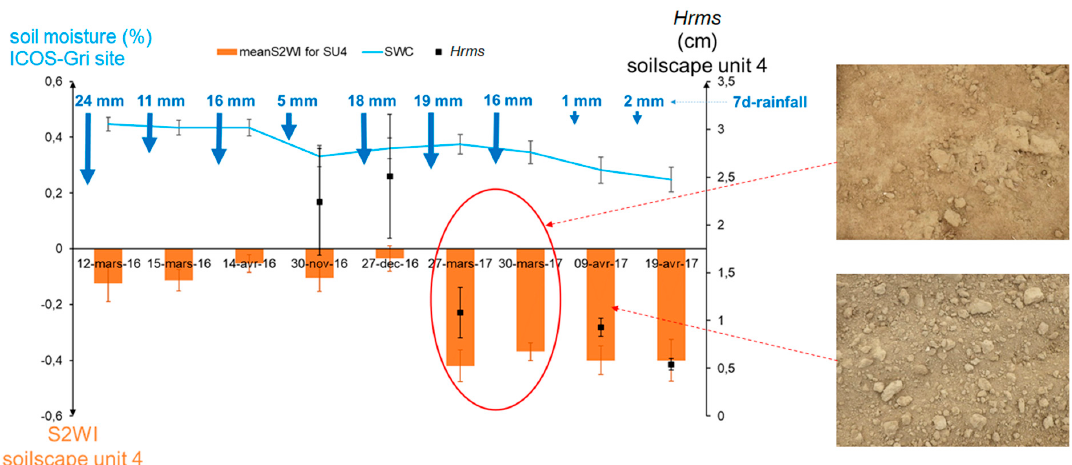
Figure 8. Evolution of S2WI according to volumetric soil moisture and soil surface roughness Hrms for the soilscape unit 4, with photographs of soil surface conditions of early and late spring 2017. Error bars for the Hrms refer to the standard deviation of Hrms values for the soil sample locations pertaining soilscape unit 4.